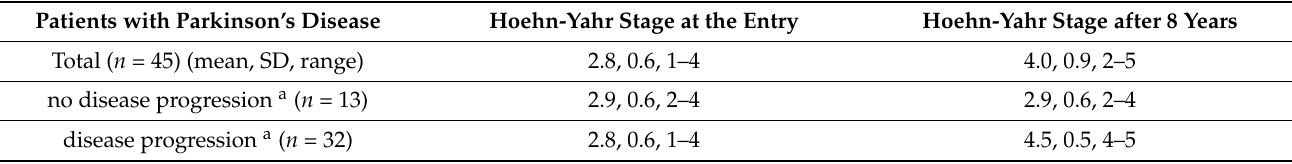
Table 1. Hoehn-Yahr stage of subjects with Parkinson’s disease in our study.